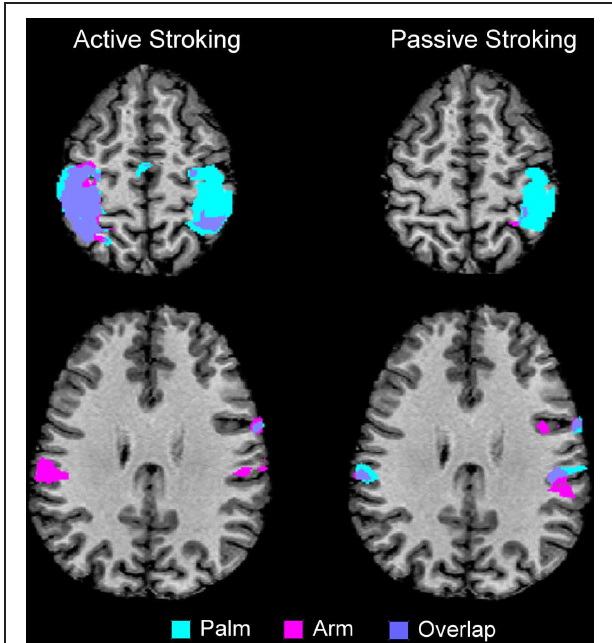
FIGURE 1 | Overview of the main regions where positive BOLD signal changes were found for active and passive stroking on the palm and arm, compared to the resting baseline. There were clear differences between active and passive touch, as can be seen in the BOLD signal in the left SI and MI (compare the top two panels). There were also body site differences: the right SI had large regions of activity from palm stroking, whereas much less activity was found to arm stroking (see also Table 1 ). There was also bilateral SII activation to arm stroking, whereas bilateral activity for palm stroking was only found for passive touch (in active touch to the palm, there was only right SII activity). The maps are to neurological convention (left is